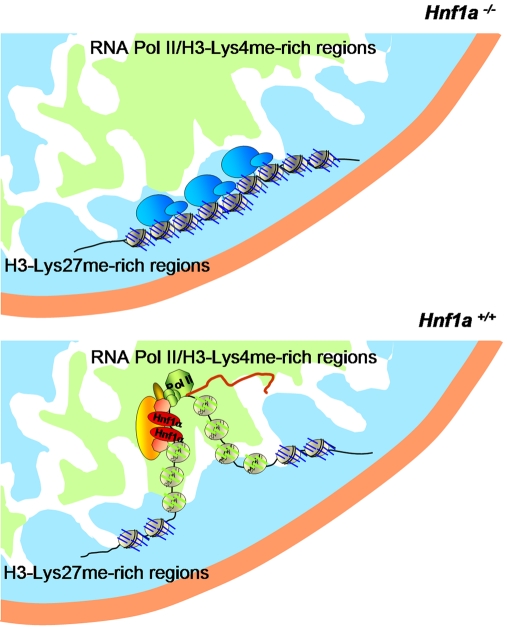
Summary model. Hnf1a−/−.
In the absence of Hnf1α, target nucleosomes exhibit increased trimethylated H3-Lys27, and are more likely to be located in peripheral nuclear domains with condensed chromatin enriched in methylated H3-Lys27. Hnf1a+/+: In wild-type cells, Hnf1α binding recruits complexes that lead to site-specific histone acetylation, H3-Lys4 methylation, and chromatin remodeling, while preventing trimethylation of H3-Lys27. This chromatin configuration is associated with relocalization to transcriptionally active, more centrally located nuclear subregions enriched in RNA polymerase II and H3-Lys4me2. We propose that activator-dependent local chromatin changes may be instrumental in gene positioning.